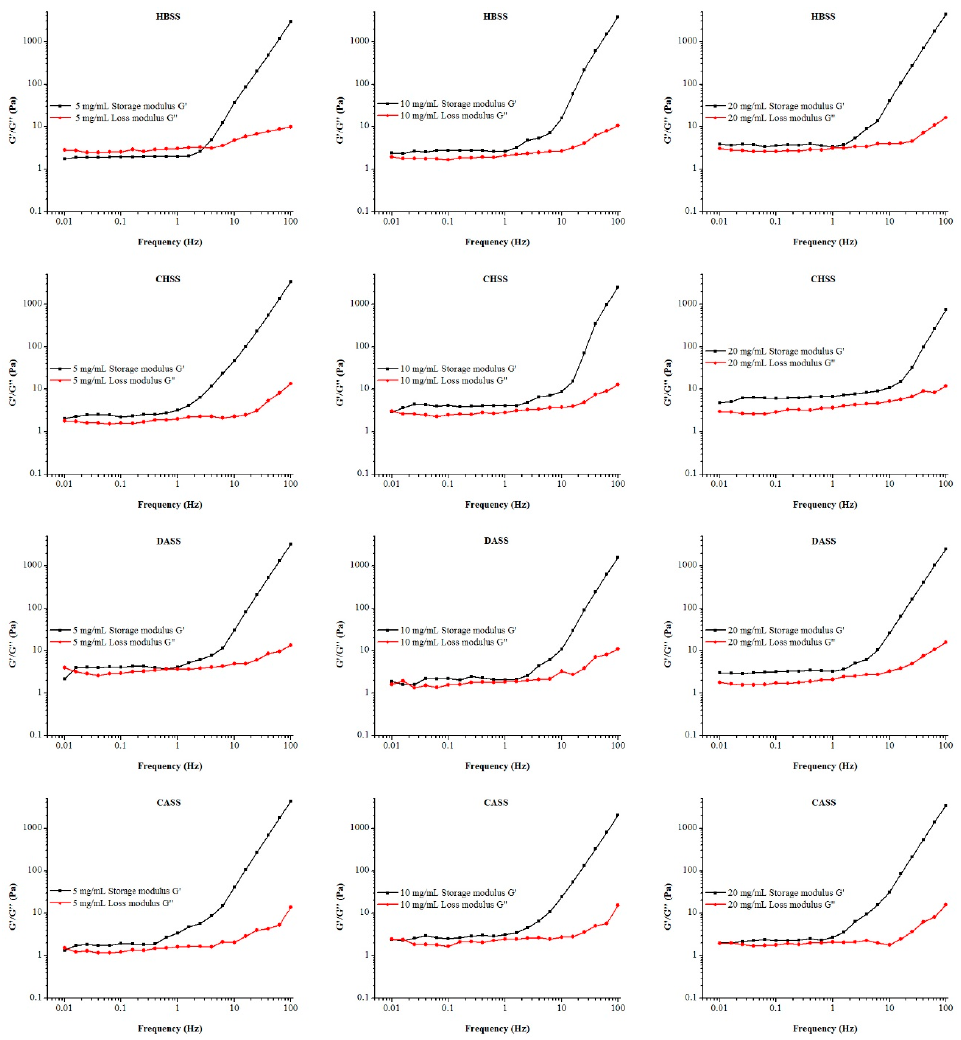
Figure 9. Frequency sweeps at 1% strain to determine the G’ (storage modulus) and G’’ (loss modulus) of MLPs at different concentrations.